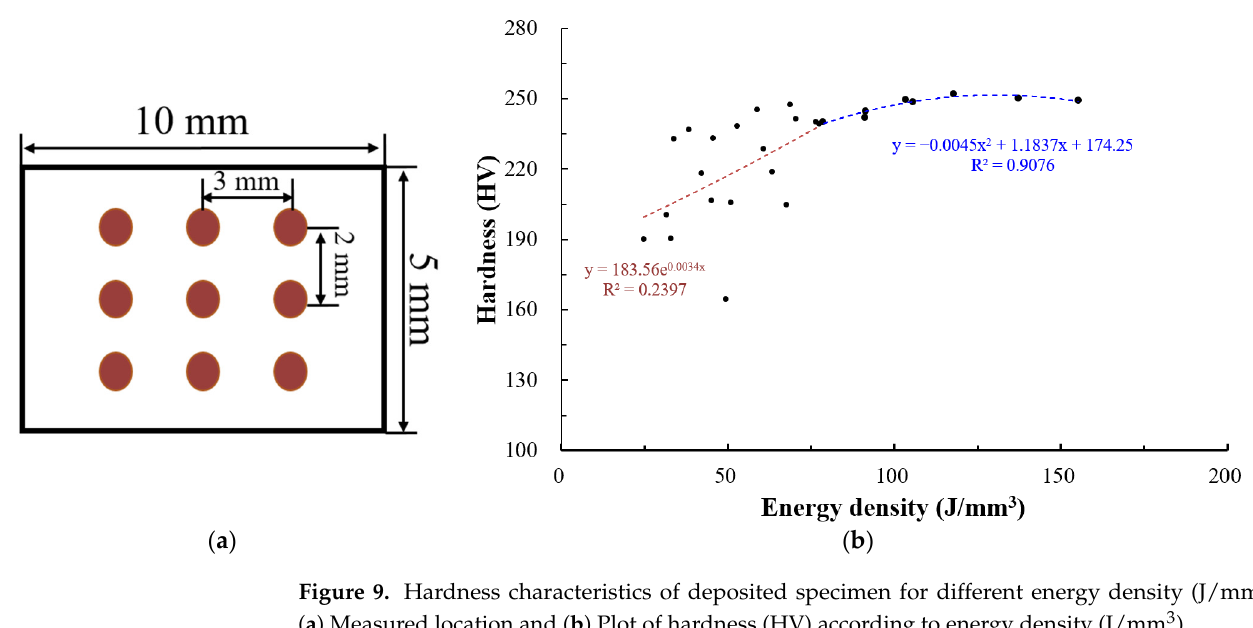
Figure 9. Hardness characteristics of deposited specimen for different energy density (J/mm 3 ): ( a ) Measured location and ( b ) Plot of hardness (HV) according to energy density (J/mm 3 ).